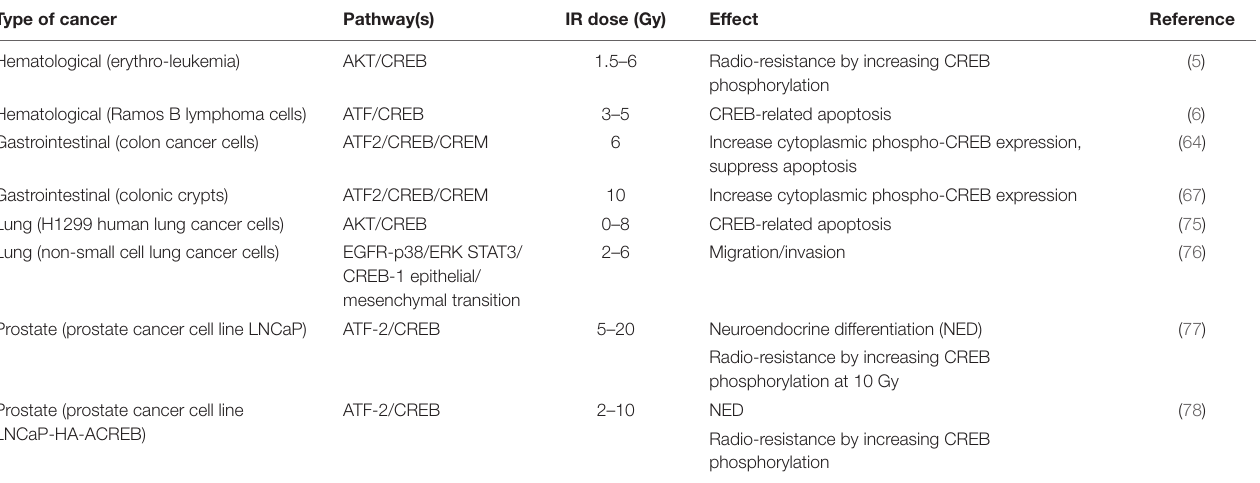
TABLe 1 | involvement of cyclic AMP response element binding (CReB) pathway in different types of cancer cells after exposure to X-ray ionizing radiation (iR) treatment. Type of